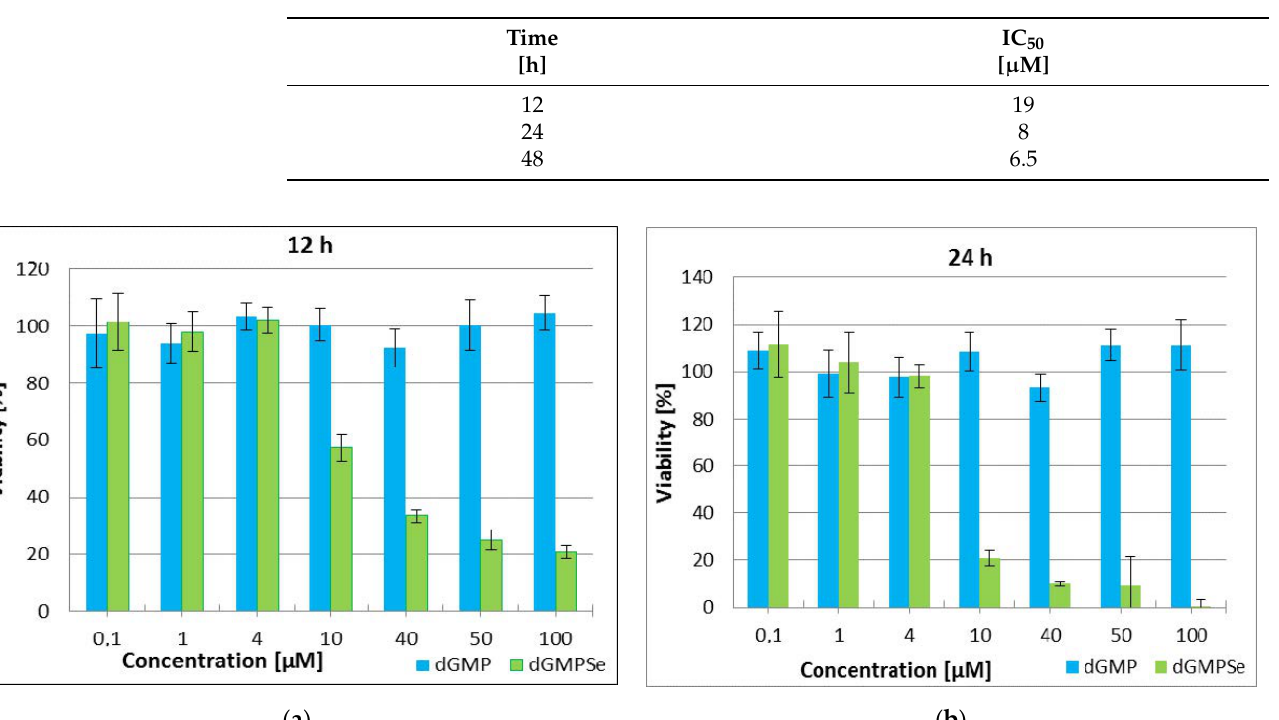
Table 3. IC 50 values of dGMPSe determined by MTT assay in HeLa cancer cells after 12, 24 and 48 h.